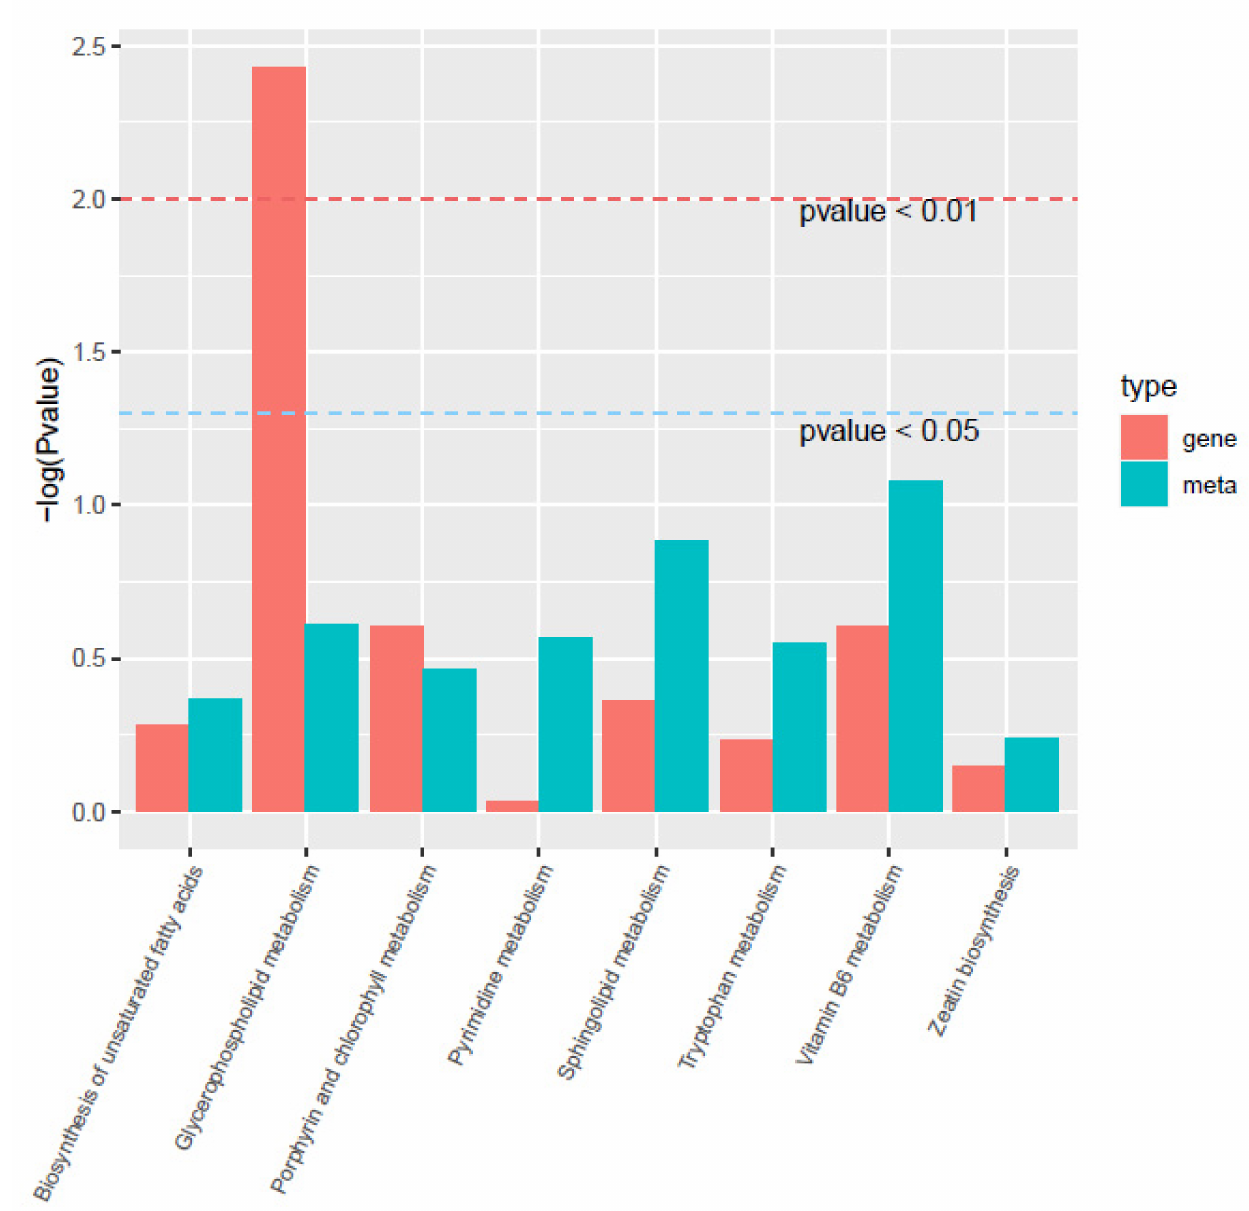
Figure 10. The KEGG enrichment of differentially expressed genes and